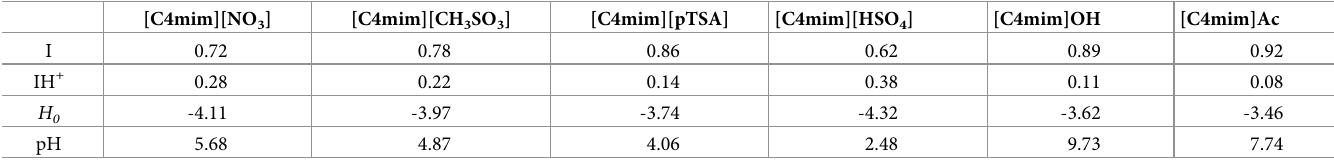
Table 1. Determination of acidity by Hammett acidity